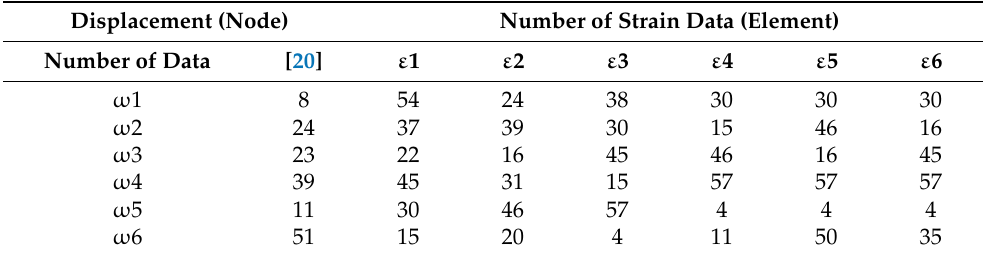
Table 7. Sensor location in the FEM model used for estimation (strain with